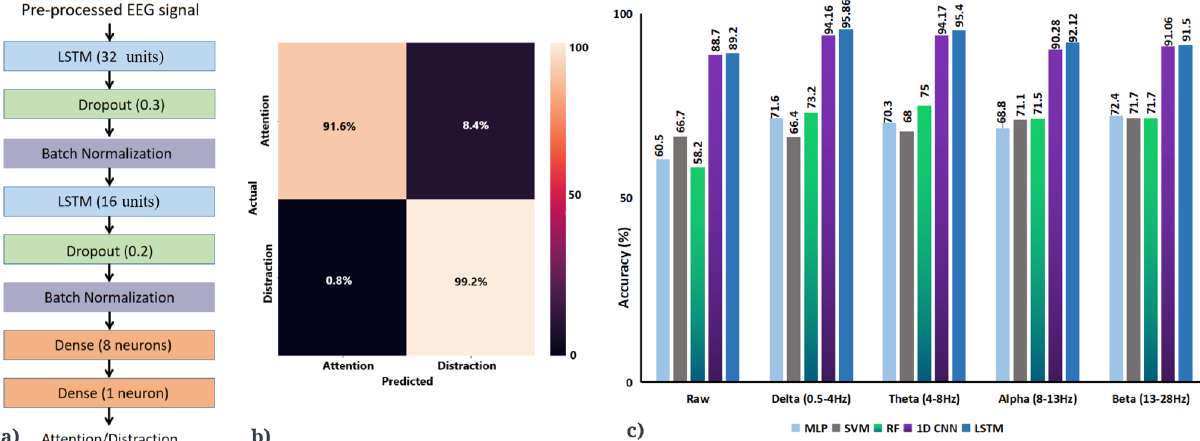
Figure 5. (a) LSTM architecture that predicted the attentional states with best accuracy. (b) Confusion matrix corresponding to test data in theta band for the dataset using LSTM which gave the maximum accuracy out of the various classifiers that were tested. (c) Comparison of classification accuracy on the basis of different data aspects for the test dataset. Delta (0.5–4 Hz) and theta (4–8 Hz) activity were most predictive of attentional data were split into training, validation and test set in the ratio of 60:20:20 respectively 40,41 . We experimented with various models, trying different permutations of layers, regularizers, optimizers, batch size, window size and activation function. The models that performed the best are reported in the manuscript. A 3-layer MLP with 16, 8 and 4 neurons in each layer, learning rate of 0.001, batch size 32, and Adam optimiser 42 (alpha = 0.001, beta1 = 0.9, and beta2 = 0.999) gave the highest accuracy of 72.4% in the beta wave. SVM with kernel as radial basis function gave the highest accuracy of about 71% in the alpha and beta wave. The ensembling technique of random forest of 50 decision trees each with maximum depth of 16 and Gini impurity criterion gave the maximum accuracy of 75% in the theta wave. 1D-CNN layer with 512 filters and 5 kernel size, followed by batch normalization 43 , dropout 44 (0.4) and a fully-connected layer with sigmoid activation gave the maximum accuracy of 94.17% in the theta wave. After experimentation the LSTM architecture in Fig. 5a was found to give the best accuracy of accuracy of 95.86% and 95.4% for delta and theta waves. The learning rate, batch size, optimizer, sequence size for both reported models of 1D-CNN and LSTM were 0.001, 32, Adam 42 (alpha = 0.001, beta1 = 0.9, and beta2 = 0.999) and 32 respectively. Figure 5c summarises the results obtained from various classifiers for each brain wave. LSTM predicts the states of distraction with a high accuracy of 99.2% but classifies approximately 8.4% of attention labels as distraction as shown in the confusion matrix cor- responding to the theta wave in Fig. 5b. Refer to the Supplementary Methods for more information on classifiers.